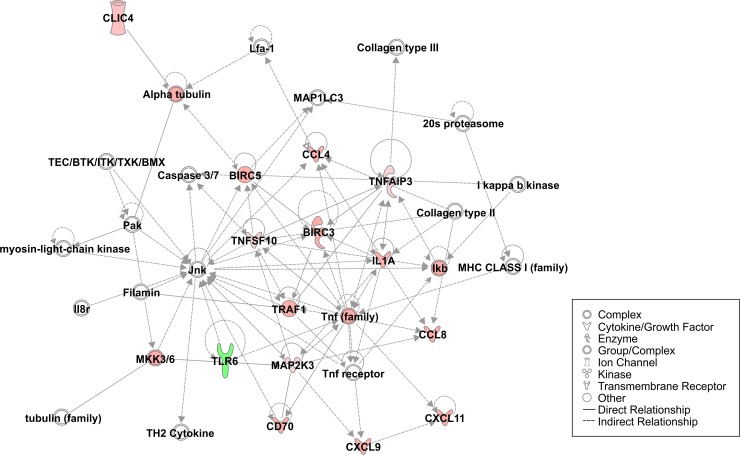
Top cell signaling network induced in tumor-primed NK (TpNK) cells as generated by Ingenuity pathway analysis.Nodes represent genes that are either upregulated (red), downregulated (green), or absent from our original differential expression analysis (white), but play an important role in the tumor-specific signaling network according to Ingenuity Pathway Analysis. The intensity of node color signifies the extent of change in expression of the respective gene relative to NK cells incubated in medium alone. Node shapes and the relationships between different genes are outlined in the figure legend.